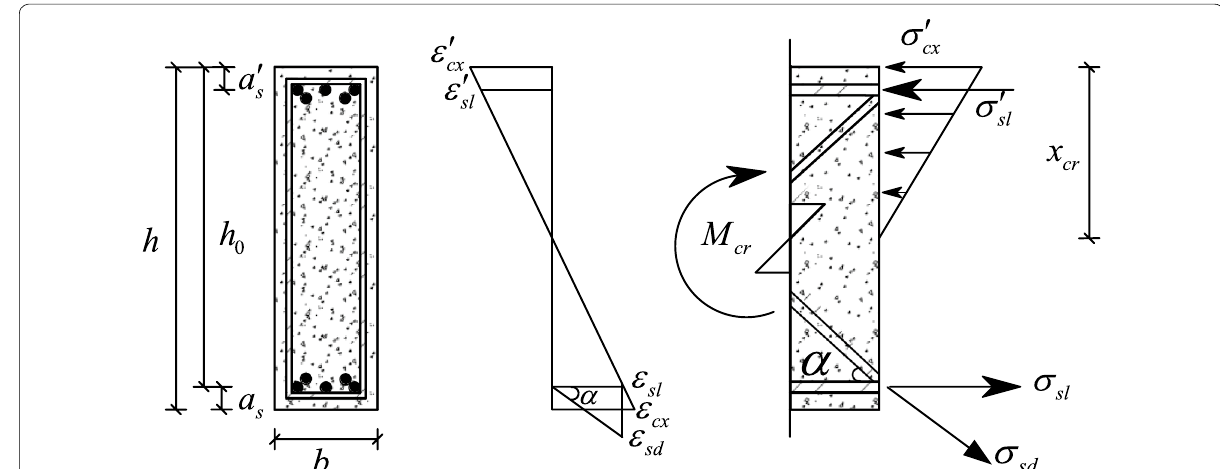
Fig. 6 The computational diagram for cross-section of diagonally reinforced coupling